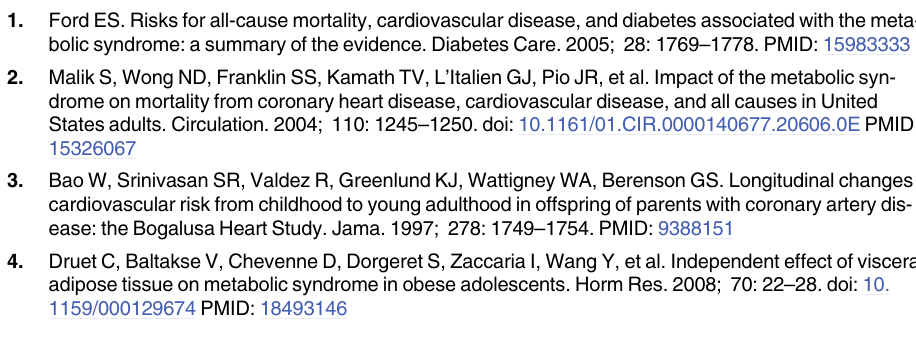
S4 Table. Effect of sex on the association between serum adiponectin/visceral fat area groups and the incidence of metabolic syndrome. Data was presented as odd ratio (95% con- fidence interval). OR, odd ratio; 95% CI, 95% confidence